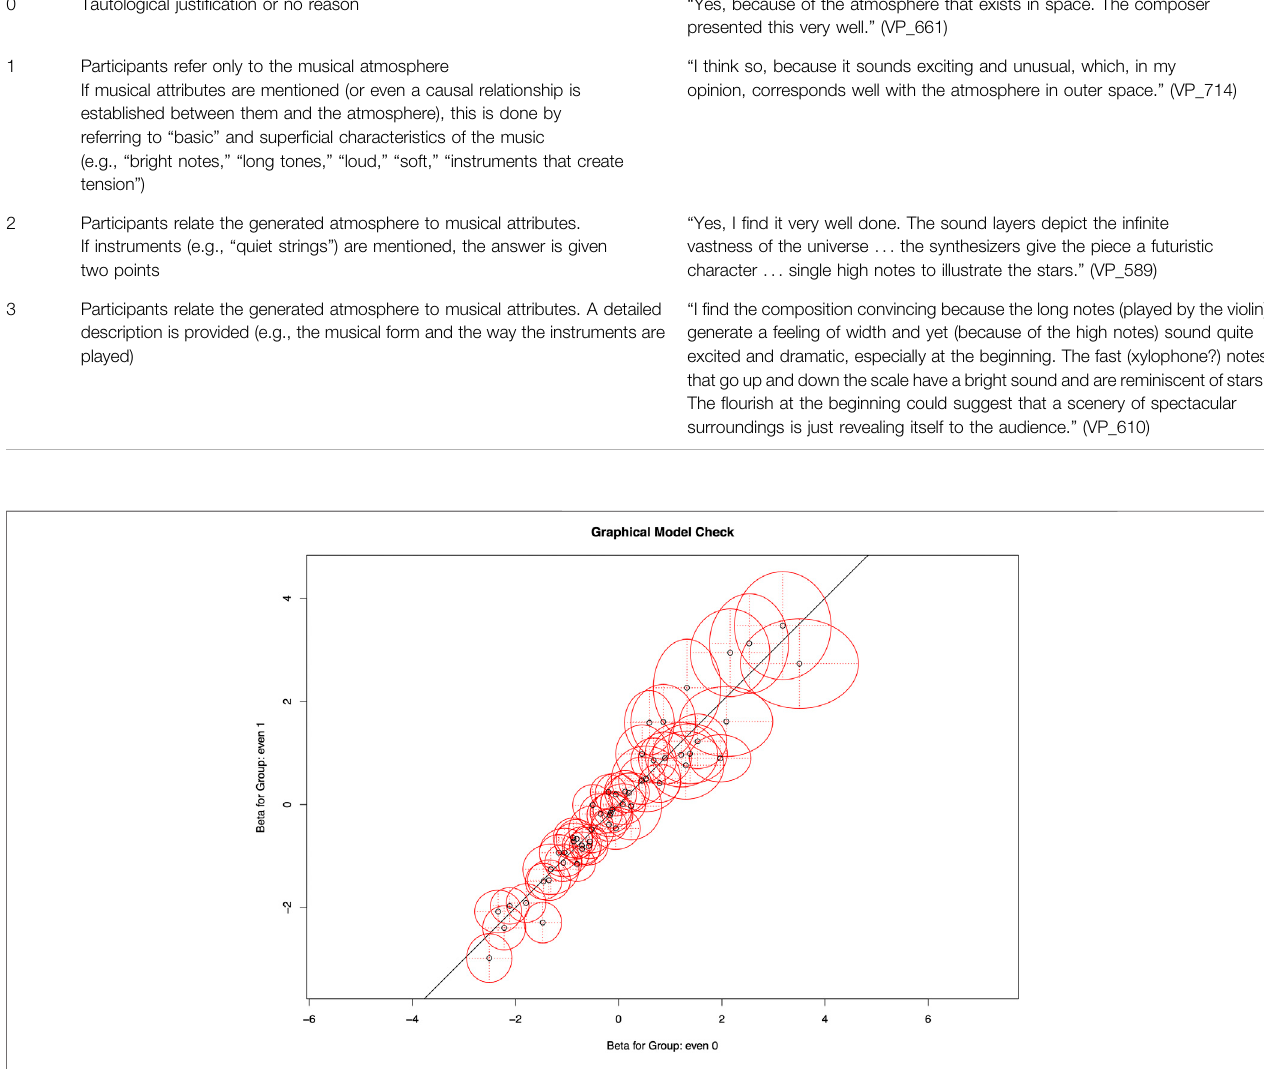
FIGURE 2 | Graphical model test (split criterion: even-uneven case